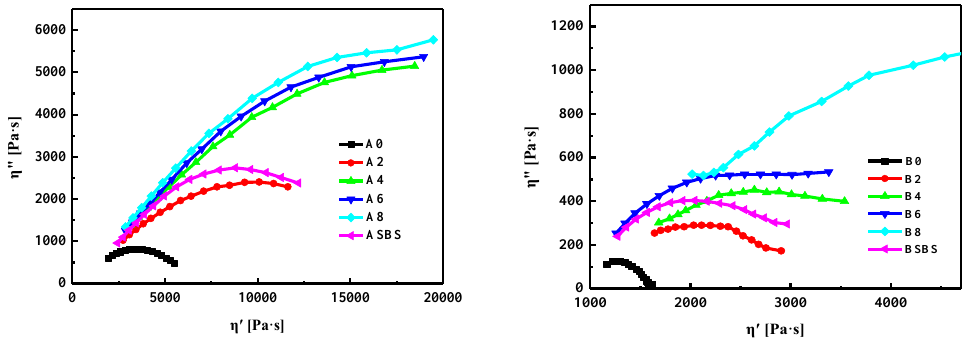
Figure 9. Cole‐Cole plots of the base and SBS latex‐modified asphalts. Figure 9. Cole-Cole plots of the base and SBS latex-modified